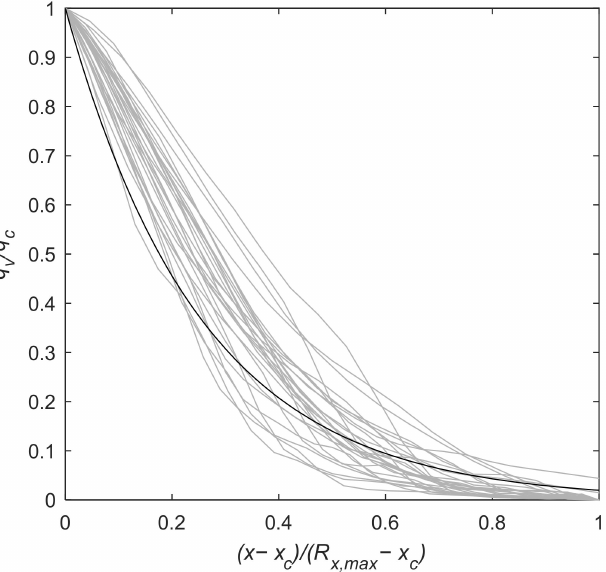
Figure 10. Overtopping discharge normalised by the overtopping discharge at the crest during 2DR as a function of incursion distance for each segment. The grey lines indicate the data for each segment and the solid black line shows Equation (12). Note that 20 min segments where the entire structure was overtopped such that overtopping events reached the sand beach landward of the revetment ( x = 275.1 m) were excluded from this